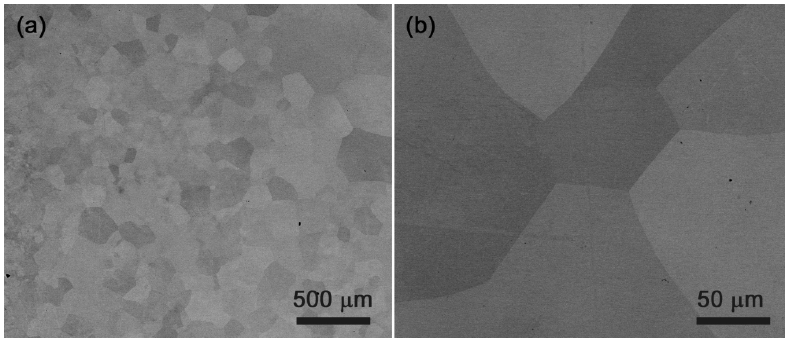
Figure 9. SEM micrographs (back-scattered electrons) of HfNbTaTiZr alloy annealed at 1200 °C: ( a ) an overview of the microstructure ( b ) detail of the microstructure taken in higher magnification.